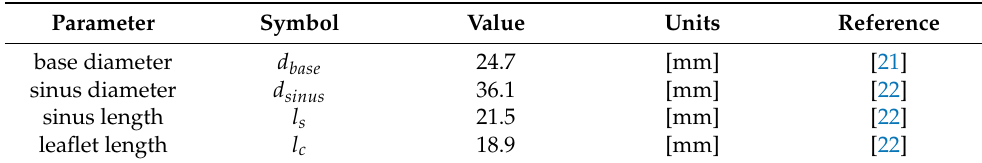
Figure 1. Simplified aortic valve geometry: ( a ) schematic representation, where d base is the base diameter, φ is the valve angle, l c is the length of the valve leaflet, l s is the length of the sinus and d sinus is the sinus diameter; ( b ) 2D computer aided design (CAD) model used as the simulation domain; the size of the simulation domain was reduced by using a symmetry plane along the axis, as shown in ( b ); ( c ) the computational domain, shown in black with boundary conditions, as imposed on the geometry. Table 1. Aortic valve